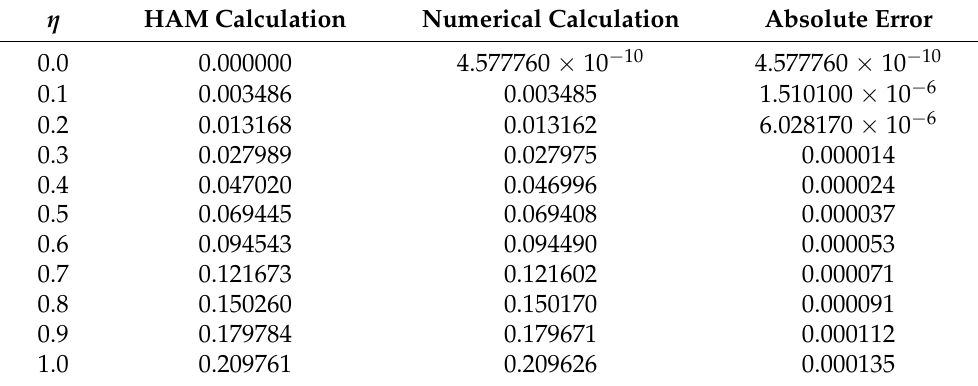
Table 1. Comparison between the analytical (HAM) and numerical results for f ( η ) .